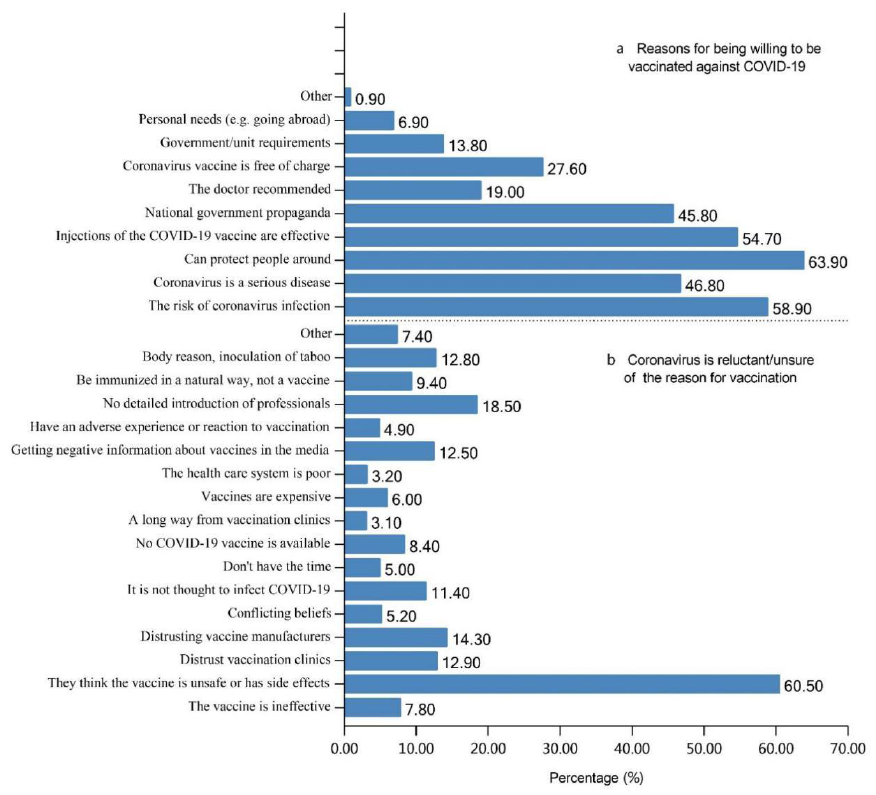
Figure 4. Reasons for COVID-19 vaccination ( a ) willingness and ( b ) refusal.